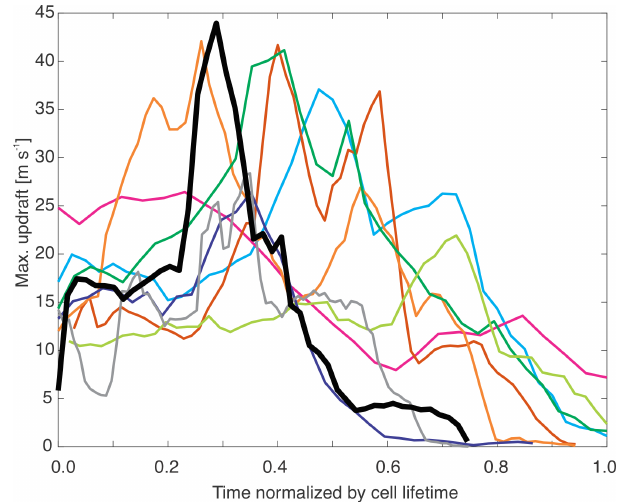
Figure 7. Maximum updraft velocity in the cell column at each time represented as a function of the normalized lifetime for the nine deep convective cells from the CLN simulation. These cells were randomly selected, as described in Sect. 3.2, and were required to have maximum radar reflectivity greater than 45dBZ, an echo top height of 40dBZ exceeding 5km in altitude, and an echo top height of 20dBZ extending above 8km of altitude during the storm life cycle. The black line represents the target cell that was analyzed for the present OSSE. Note that because the plot displays the maximum updraft found in regions with reflectivity greater than 45dBZ, some lines do not end at time 1.0 when the maximum reflectivity is below